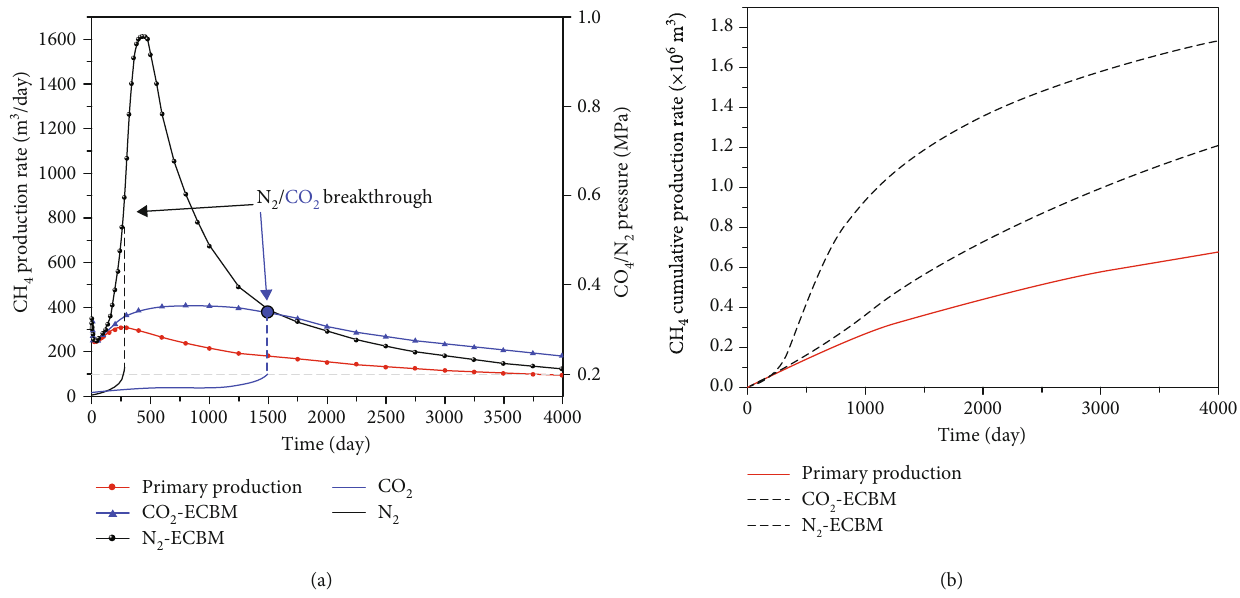
Figure 6: CH cumulative production.